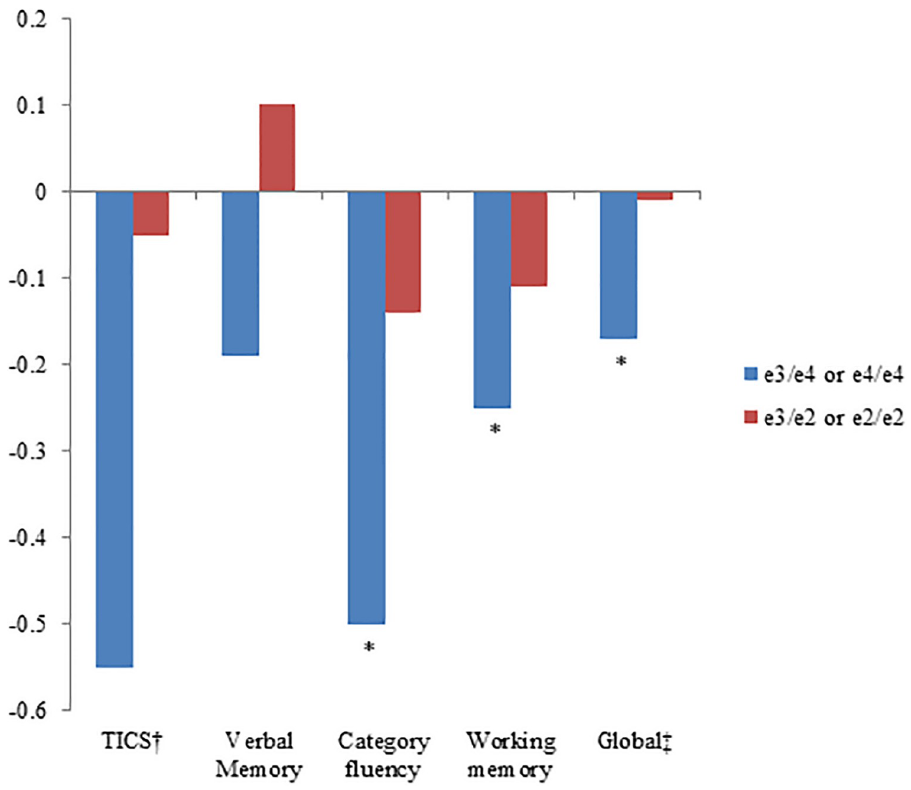
Fig 1. Multivariable-adjusted mean differences in average cognitive performance in up to 4 assessments according to apolipoprotein E genotypes compared to the e3/e3 genotype. Multivariable models adjusted for age, education, high blood pressure, high cholesterol, cigarette smoking, alcohol intake, body mass index, physical activity, aspirin use, other NSAIDs use, Vitamin E supplement use, postmenopausal hormone use, antidepressant use, mental health index and energy-fatigue index from SF-36. � P < 0.0001. † Telephone Interview of Cognitive Status. ‡Global score is the average of the z-scores of TICS, immediate and delayed recalls of East Boston Memory Test, delayed recall of TICS 10-word list, test of category fluency, digit backwards